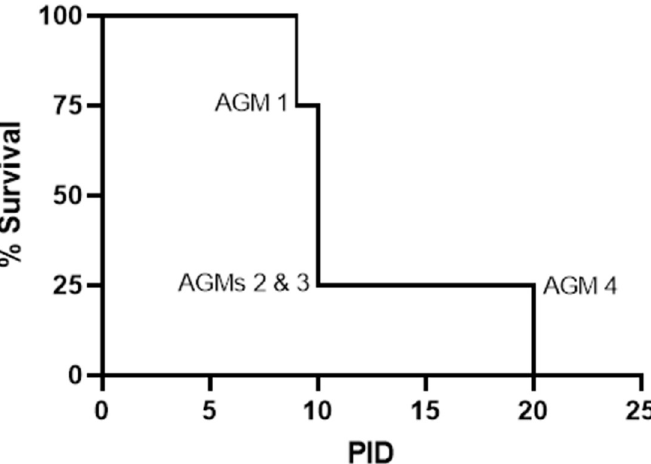
Fig 1. Kaplan-Meier survival curve. Percent survival is shown in this Kaplan-Meier survival curve.